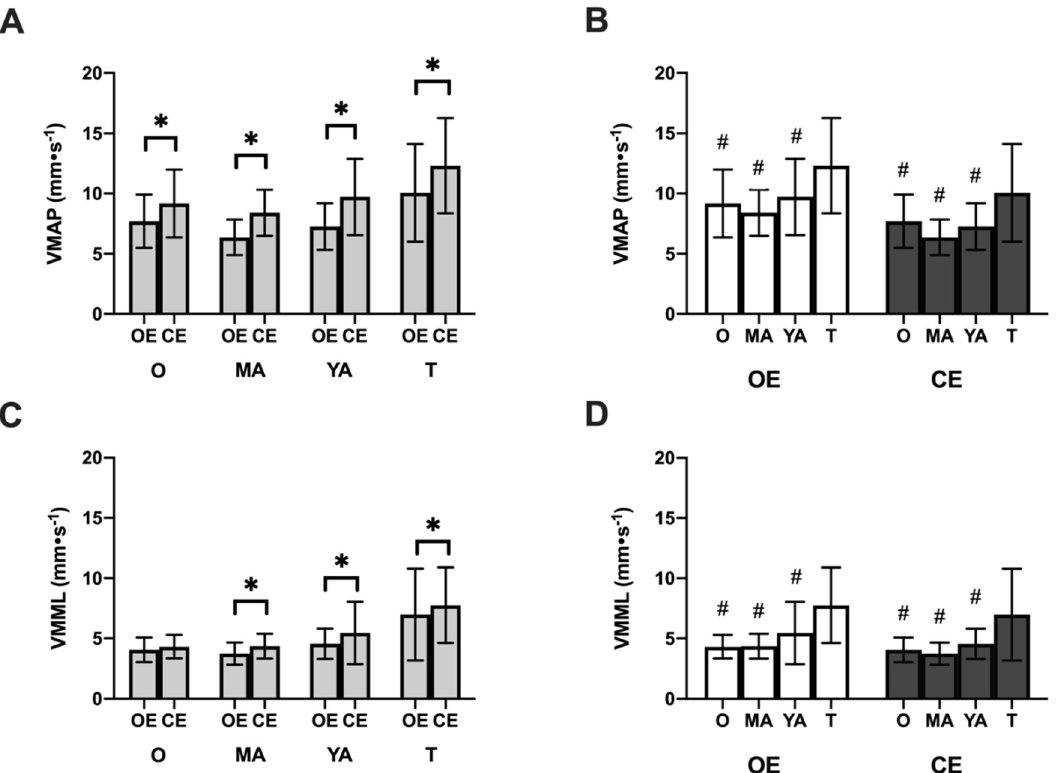
Figure 4. Scores on the balance test for the variable mean velocity of center of pressure. Mean front-to-back velocity: ( A ) Comparison by conditions (open eyes vs. closed eyes) and ( B ) Comparison by age groups. Mean velocity in medial-lateral direction: ( C ) Comparison by conditions (open eyes vs. closed eyes) and ( D ) Comparison by age group. Lower scores indicate better performance on the task. O: older adults; MA: middle-aged adults; YA: young adults; T: teenagers; OE: open eyes; CE: closed eyes; MV AP : media front to back velocity of the center of pressure; MV ML : median medial lateral velocity of the center of presser. * p < 0.001. # post hoc differences only vs. the group of teenagers, p < 0.001.